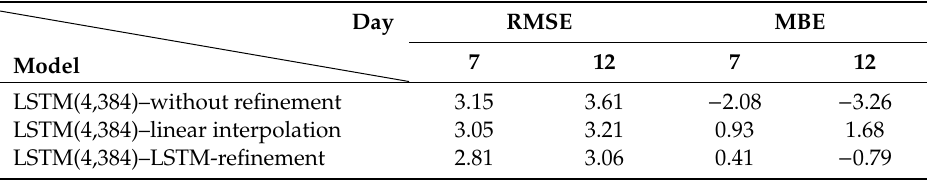
Table 7. Performance comparison of the RMSE and MBE of the LSTMs with linear interpolation and LSTM-refinement for 7 and 14 day temperature